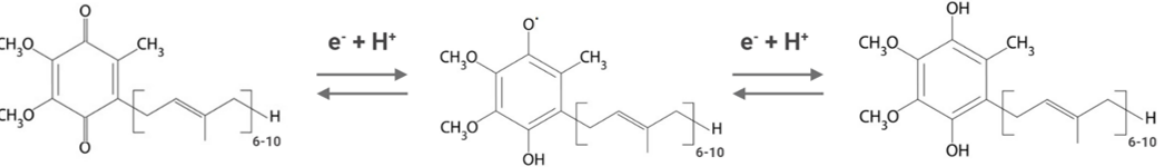
Figure 1. Different redox states of Coenzyme Q. From left to right: oxidized form (ubiquinone), semi-reduced form (semiquinone), and fully reduced form (ubiquinol). Depending on the organism, the isoprenoid chain is composed of 6 to 10 units.